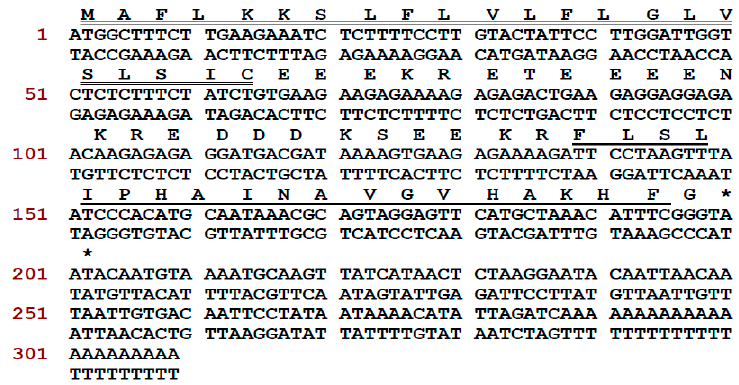
Figure 1. Nucleotide and translated open-reading frame amino acid sequences of cloned cDNA encoding the precursor of Phylloseptin-PT (PS-PT). The putative signal peptide is double-underlined, the mature peptide is single-underlined, and the stop codon is indicated by an asterisk.